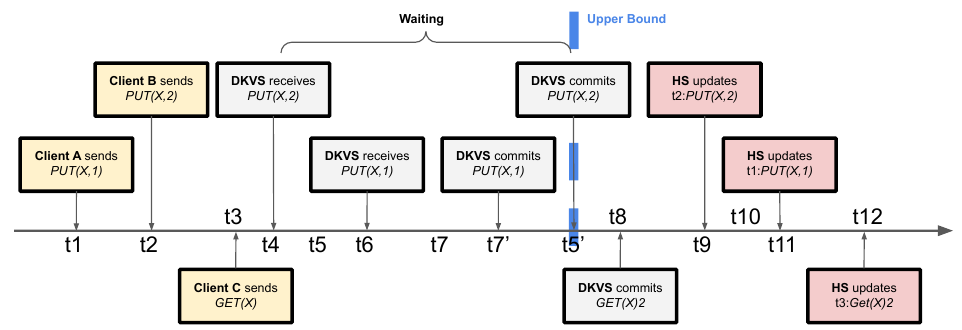
Figure 6. Delayed Commit to wait for the Upper Bound of Network Delivery Time. By waiting long enough, a DKVS can commit operations in the order that is dictated by clients’ timestamps. With this, any reordering is the indication of malicious